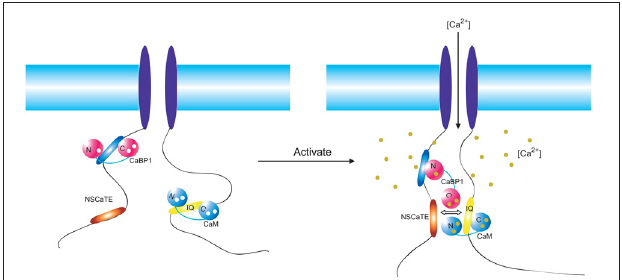
FIGURE 8 | Overview of the regulatory network of the Ca v 1.2 ( α 1c ). Two motifs (NSCaTE, Ca 2 + /CaM specific, red ; CaBP1 binding motif, blue ) in the N-terminus and the IQ motif ( yellow ) in the C-terminus are represented by oval bars . The regulatory calcium binding proteins CaBP1 and CaM are shown in red and blue , respectively. These proteins are bound to the N-terminus of the channel and the IQ motif in the resting state. Upon membrane depolarization and channel opening, both CaM and CaBP1 bind calcium ions and interact with different motifs. The cross-interference among these binding partners is critical for the distinct regulatory functions of each type of